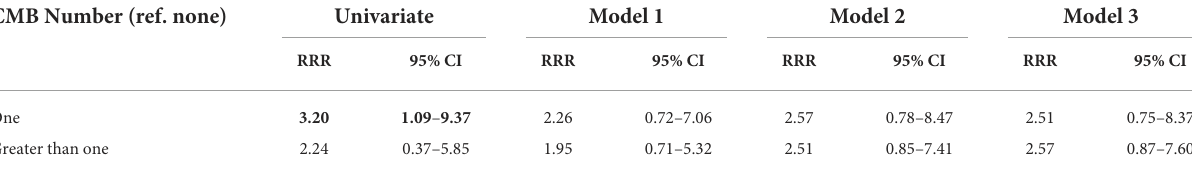
TABLE 3 Multinomial logistic regression models demonstrating the association of atrial cardiopathy with CMB number among patients with ischemic stroke ( N = 120). CMB Number (ref.